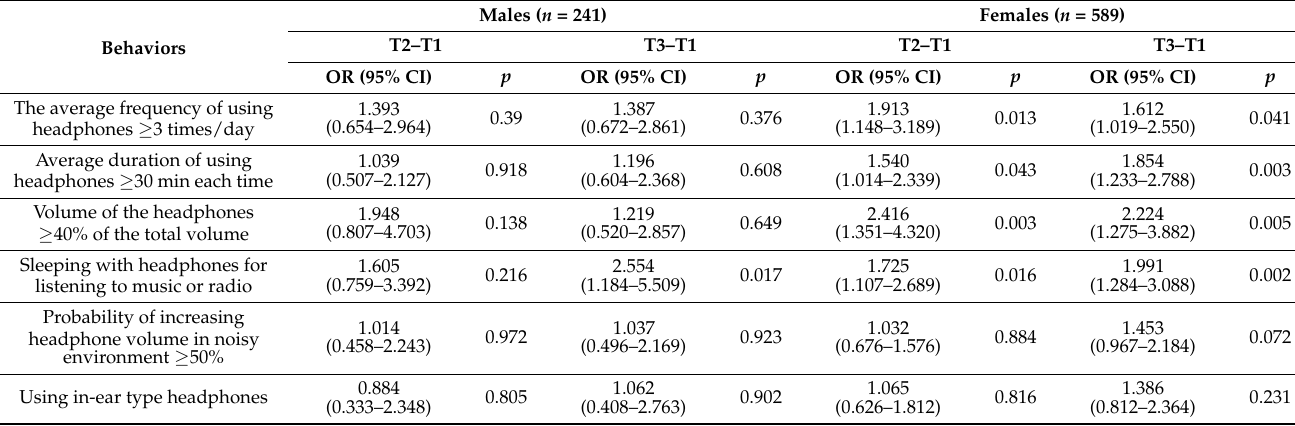
Table 3. Binary logistic regression analysis of the efficiency of intervention on the hearing health related behaviors in college